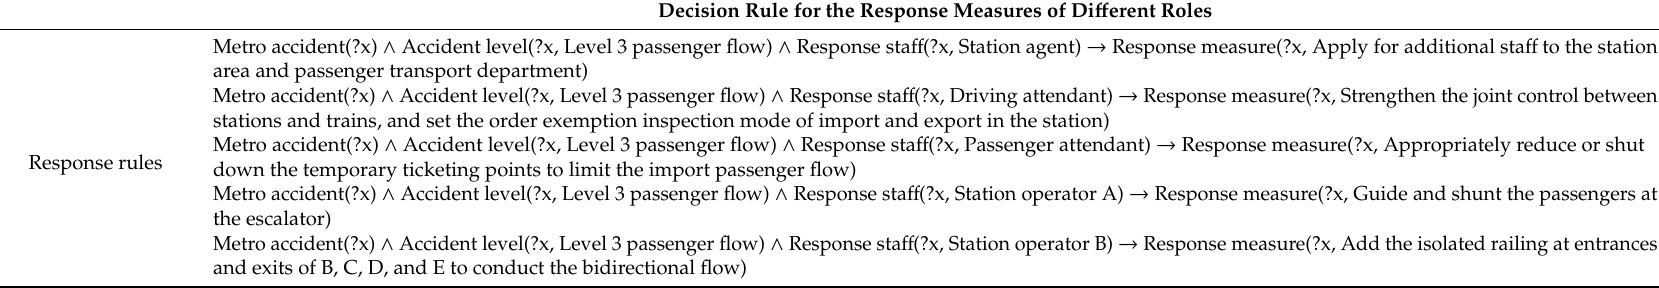
Table 6. Accident response rules for level 3 passenger